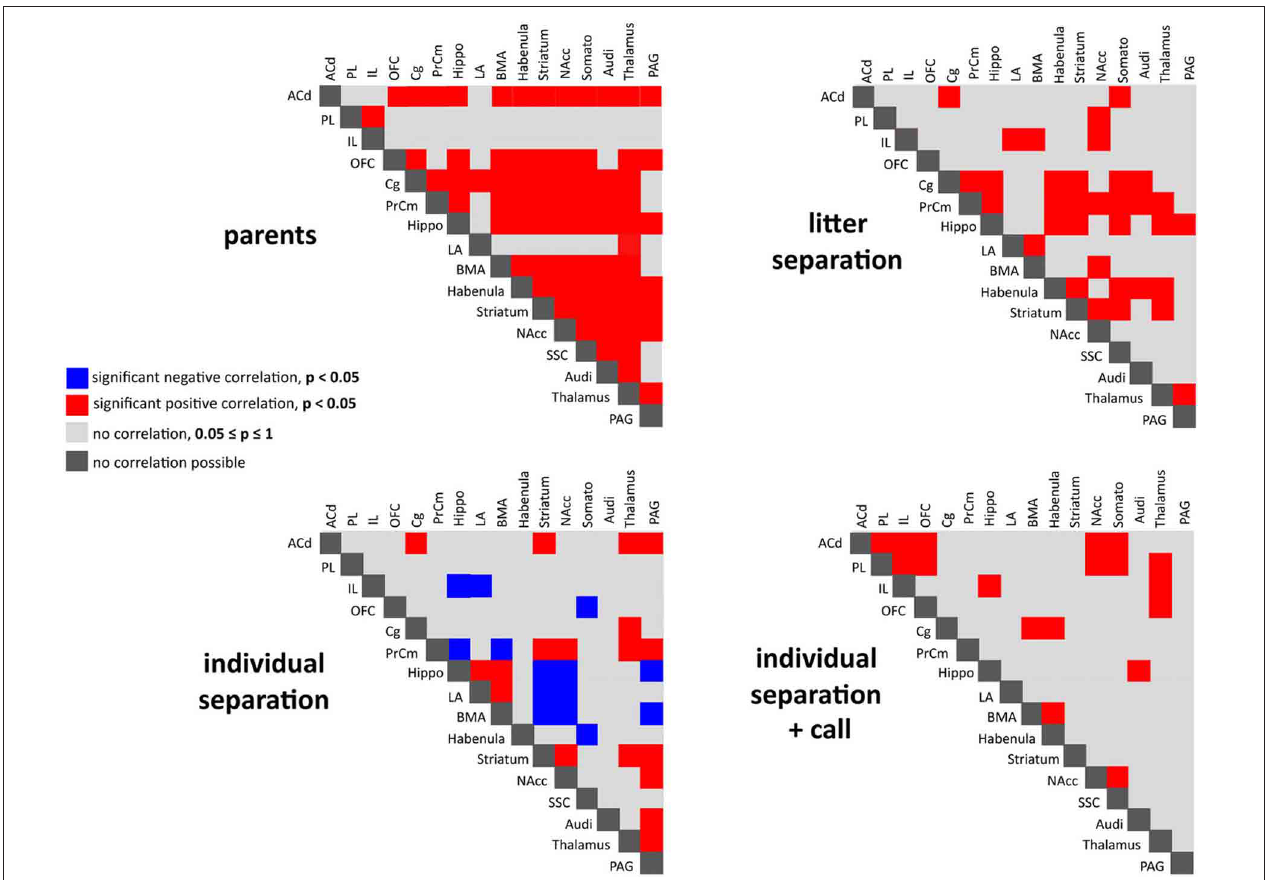
FIGURE 5 | Interregional correlations of metabolic brain activity reflecting functional coupling of the analyzed brain areas in the four experimental groups. Significant positive ( red ) and negative ( blue ) correlations analyzed using Spearman’s rank correlation coefficient ( p < 0 .